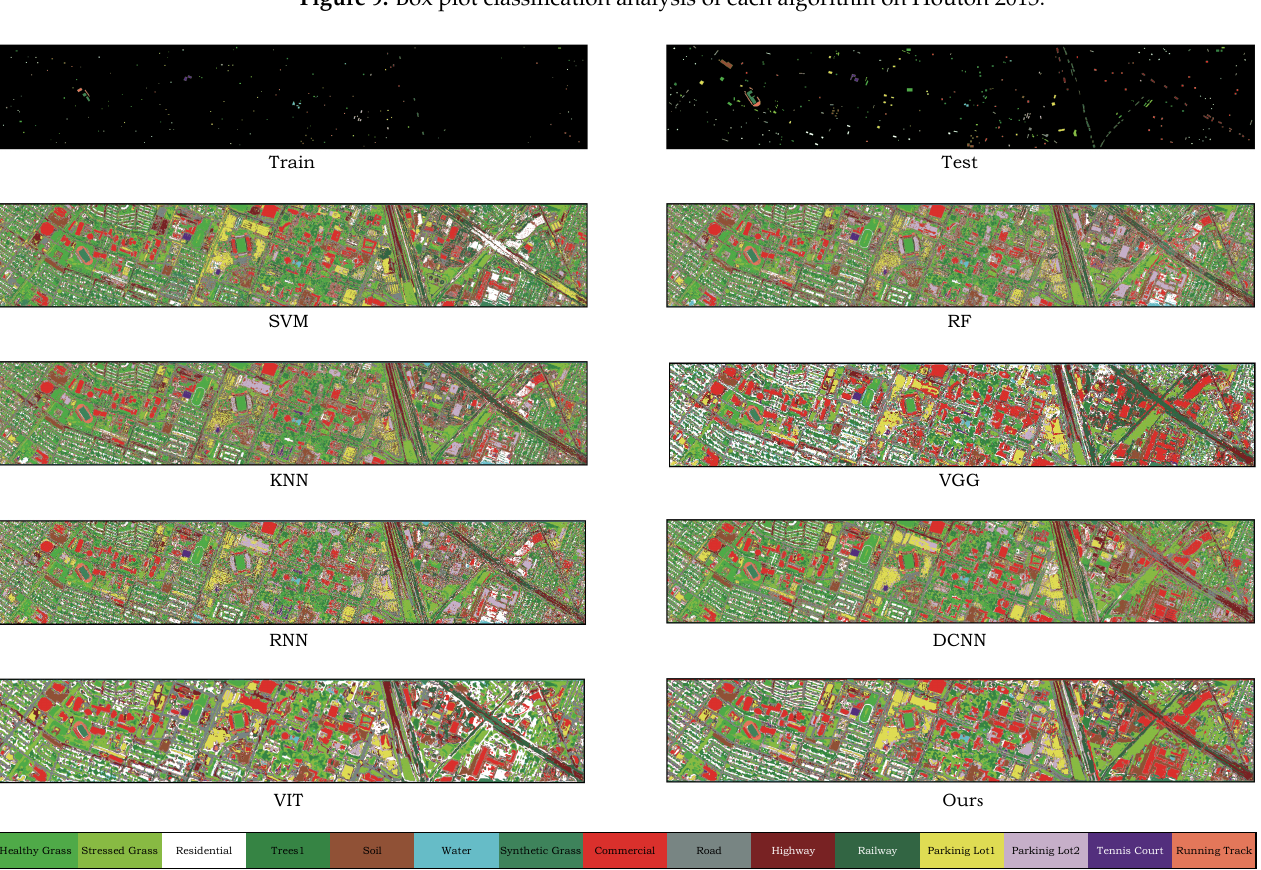
Figure 9. Box plot classification analysis of each algorithm on Houton 2013.